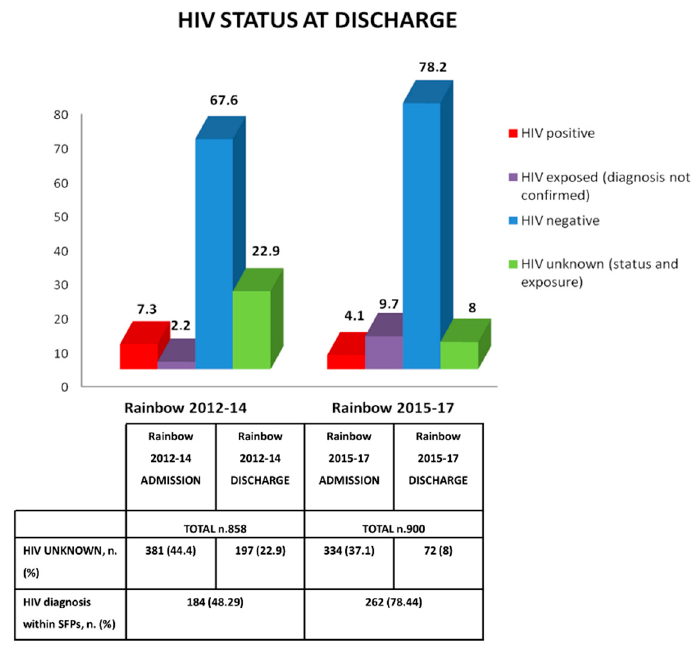
Figure 3. The HIV status at discharge: comparison between Rainbow 2012–14 and 2015–17.